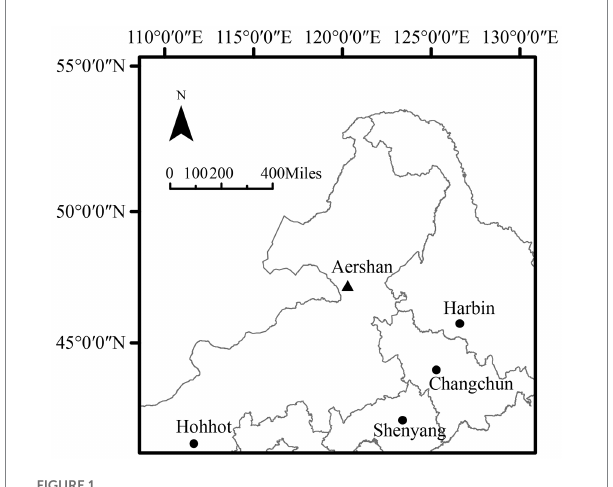
FIGURE 1 Sampling location in Aershan National Forest